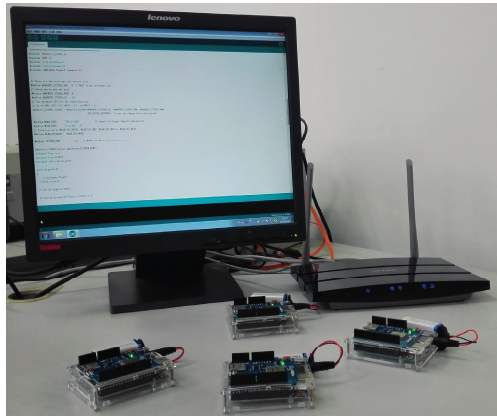
Figure 6. The experimental platform with four nodes (Arduino Uno board).